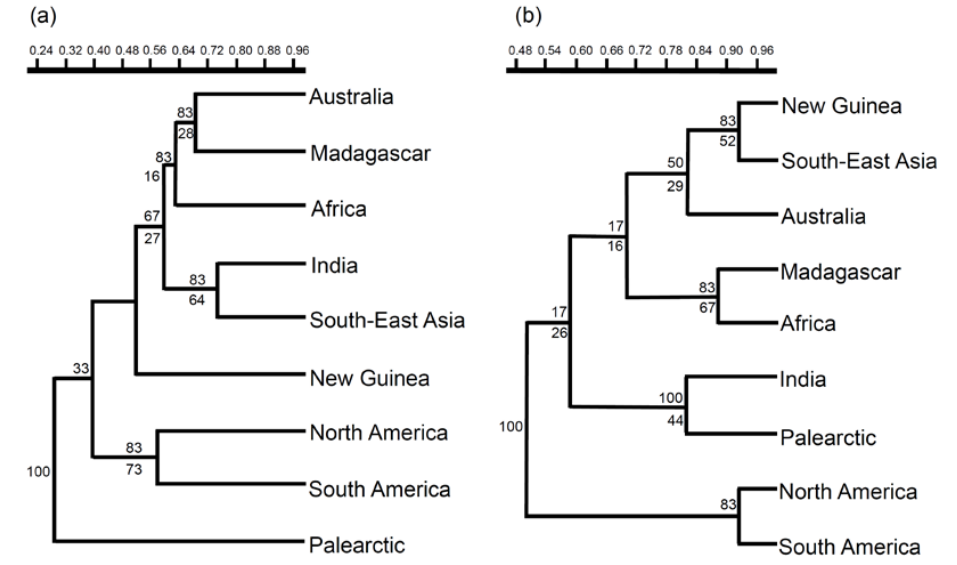
Figure 3. Cluster analysis (UPGMA) of areas of endemism based on Dice-Sørensen ( a ) and Simpson ( b ) coefficients. Numbers on branches are the percentages of times each node was repeated among different consensus rules. Numbers below branches are bootstrap values (percentages) for the consensus tree obtained after 1000 permutations of the order in which areas are analysed.